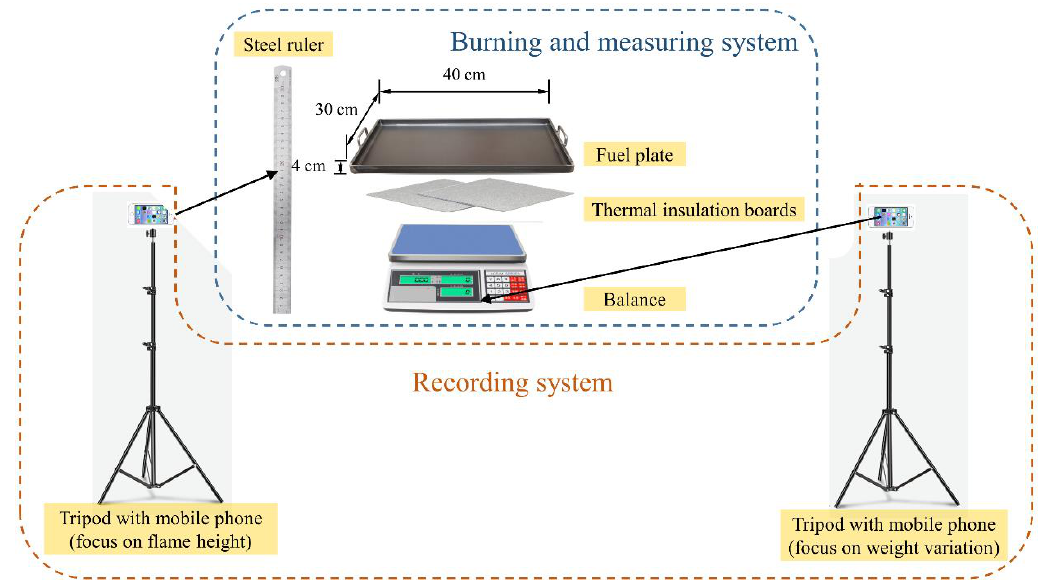
Figure 1. Schematic diagram of the test platform.